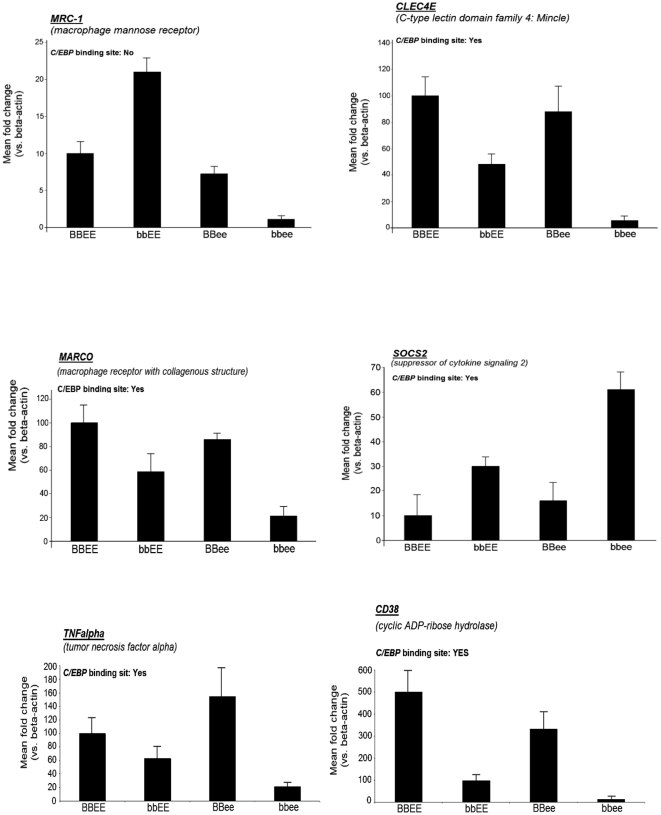
Validation of mRNA expression of Mrc1, Clec4e, Marco, Socs2, Tnfα, and Cd38 in bone marrow-derived macrophages stimulated with LPS and mIFNγ.Expression levels of macrophage mannose receptor 1 (Mrc1), C-type lectin domain family 4, member e (Clec4e), macrophage receptor with collagenous structure (Marco), suppressor of cytokine signaling 2 (Socs2), Tnfα and Cd38 mRNA in bone marrow derived macrophages stimulated with LPS and mIFNγ were determined by quantitative RT-PCR. C/EBP-binding site in the promoter region of these genes are also indicated.